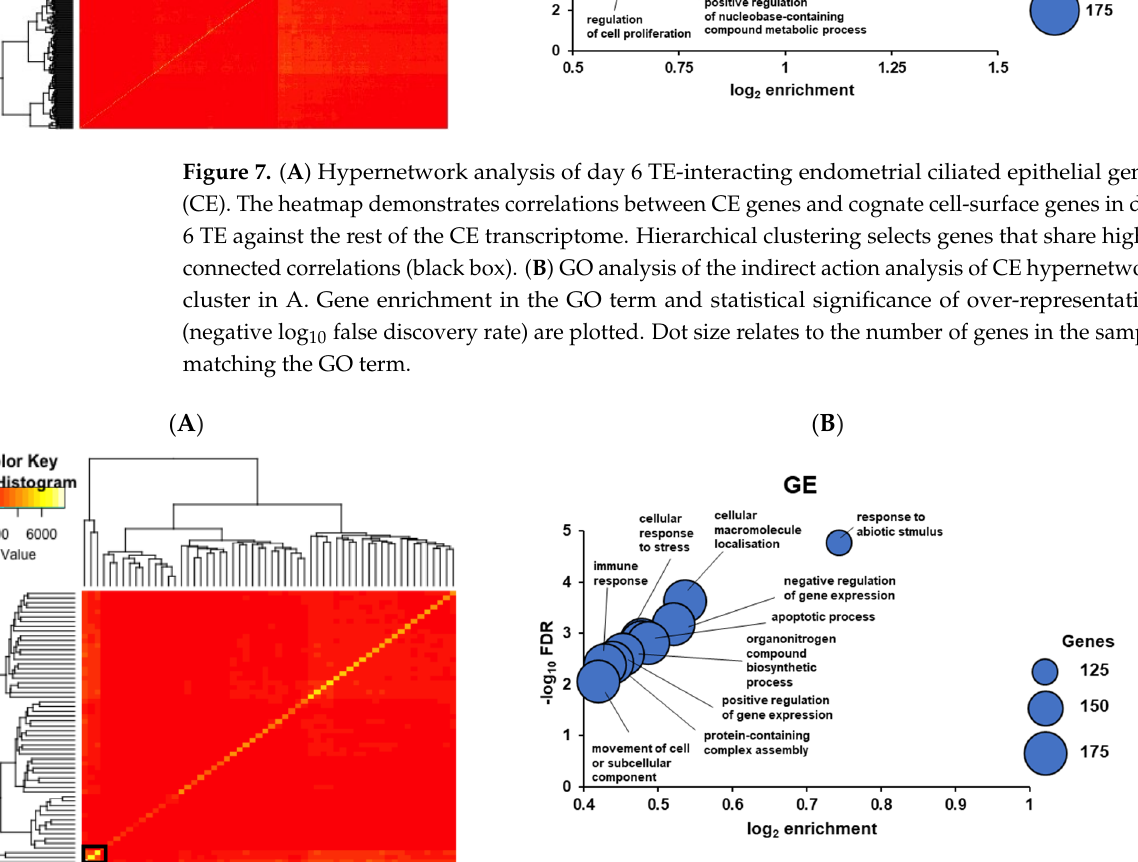
Figure 8. ( A ) Hypernetwork analysis of day 6 TE-interacting glandular epithelial genes (GE). The heatmap demonstrates correlations between GE genes and cognate cell-surface genes in day 6 TE against the rest of the GE transcriptome. Hierarchical clustering selects genes that share highly con- nected correlations (black box). ( B ) Gene Ontology (GO) of GE networks identified via indirect ac-